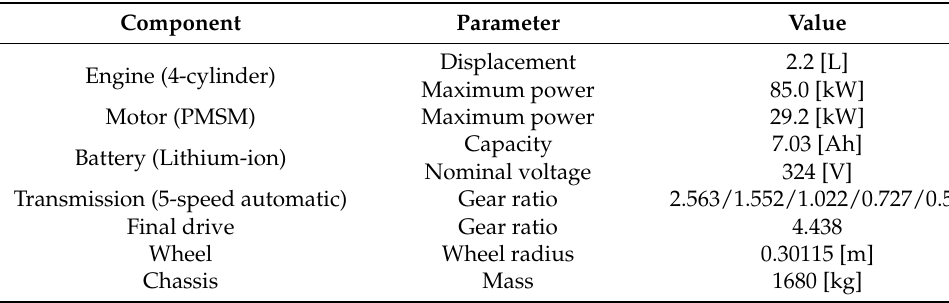
Figure 1. Structure of an HEV with a P2 powertrain. Table 1. Specification of HEV.